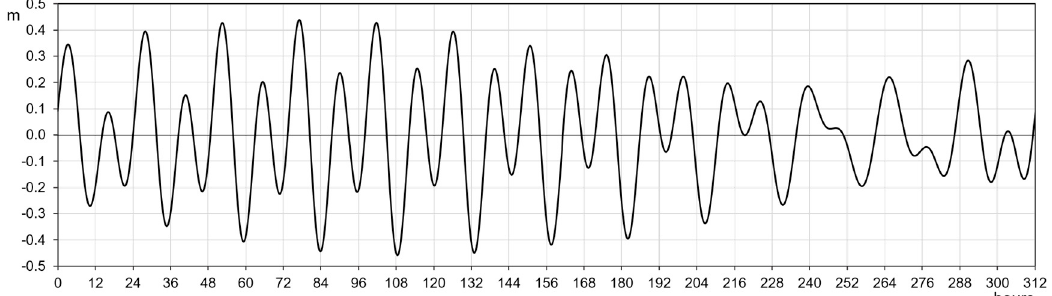
Figure 5. Sequence of the reconstructed annual average tidal level.